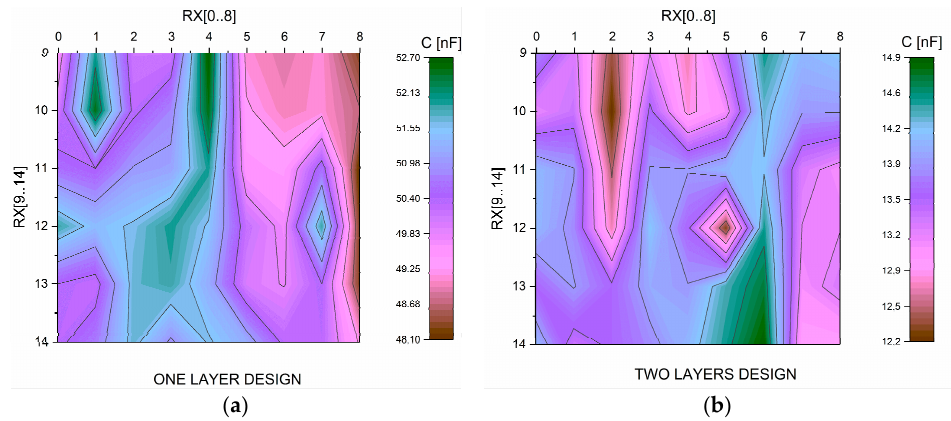
Figure 7. ( a ) Capacitance distribution on OLD; and ( b ) capacitance distribution on TLD.